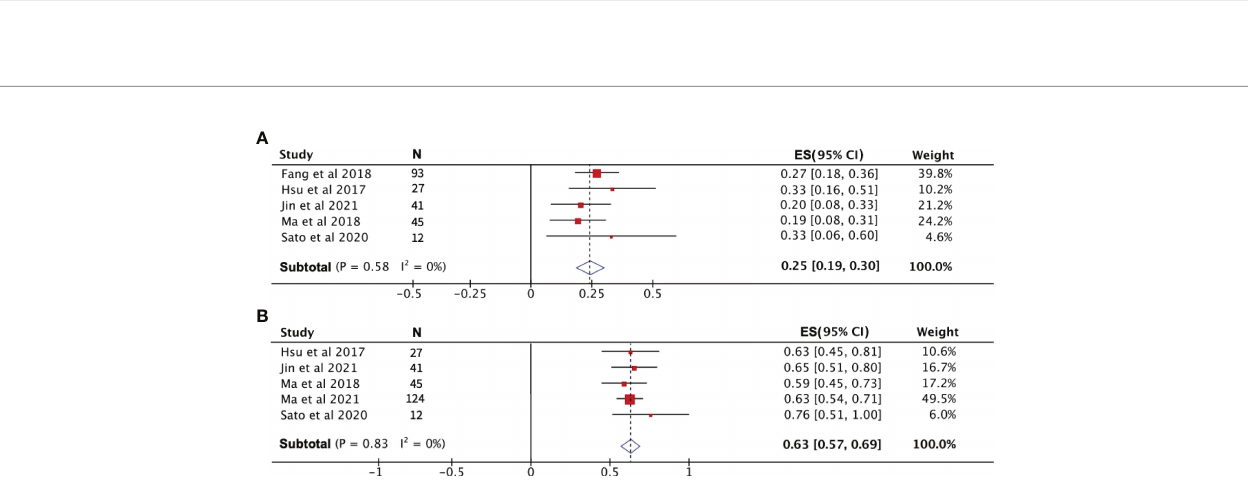
FIGURE 3 | The evaluation of disease condition in patients receiving PD-1 treatment. (A) Complete response rate. (B) Partial response rate. (C) Stable disease rate. (D) Disease control rate. (E) Objective response rate.